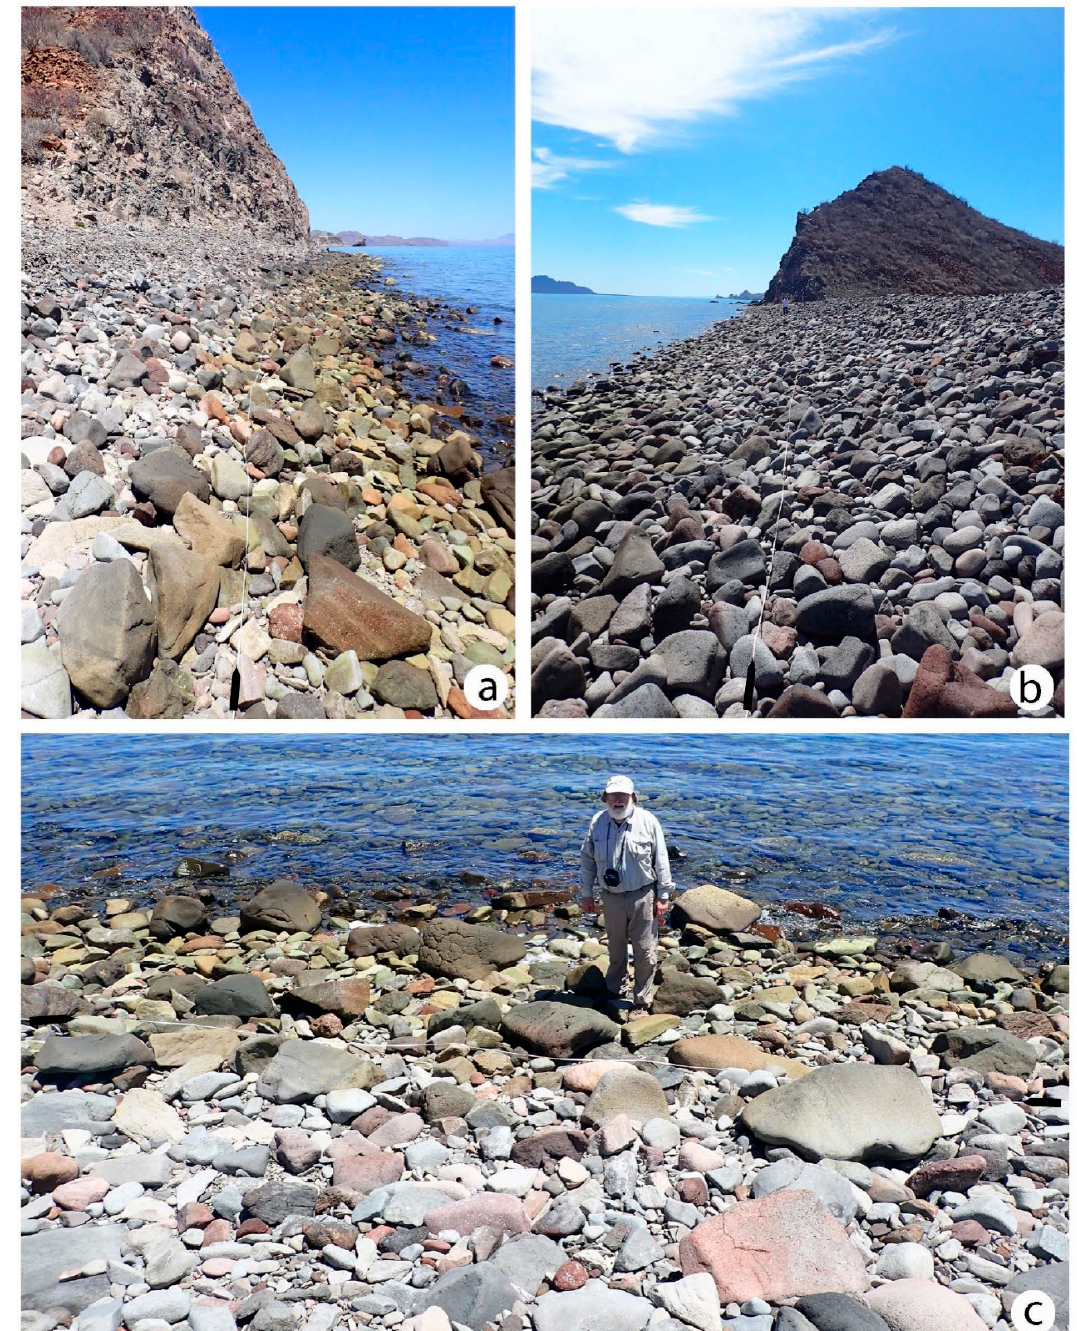
Figure 6. Boulder deposits from barrier #1; ( a ) View from the north end of the boulder deposit with the eroded cliff face of Cerro El Chino in the background; ( b ) View looking toward the south end with the eroded cliff face of an un-named islet in the distance; ( c ) View east from the center of the barrier. In each view, the anchor position of the meter tape is at the upper tide line marked by black arrows. It is worthy of note that both Cerro El Chino and the un-named islet exhibit steep sea cliffs where erosion resulted in significant coastal retreat. The effect is apparent in the asymmetry of the outer hills and related islet as registered on the topographic map (Figure 4). A view from the middle of barrier #1 looking SW shows a characteristic mixture of pebbles, cobbles, and boulders entrained in the natural breakwater (Figure 6b). Looking eastward (Figure 6c), the meter tape is extended in front